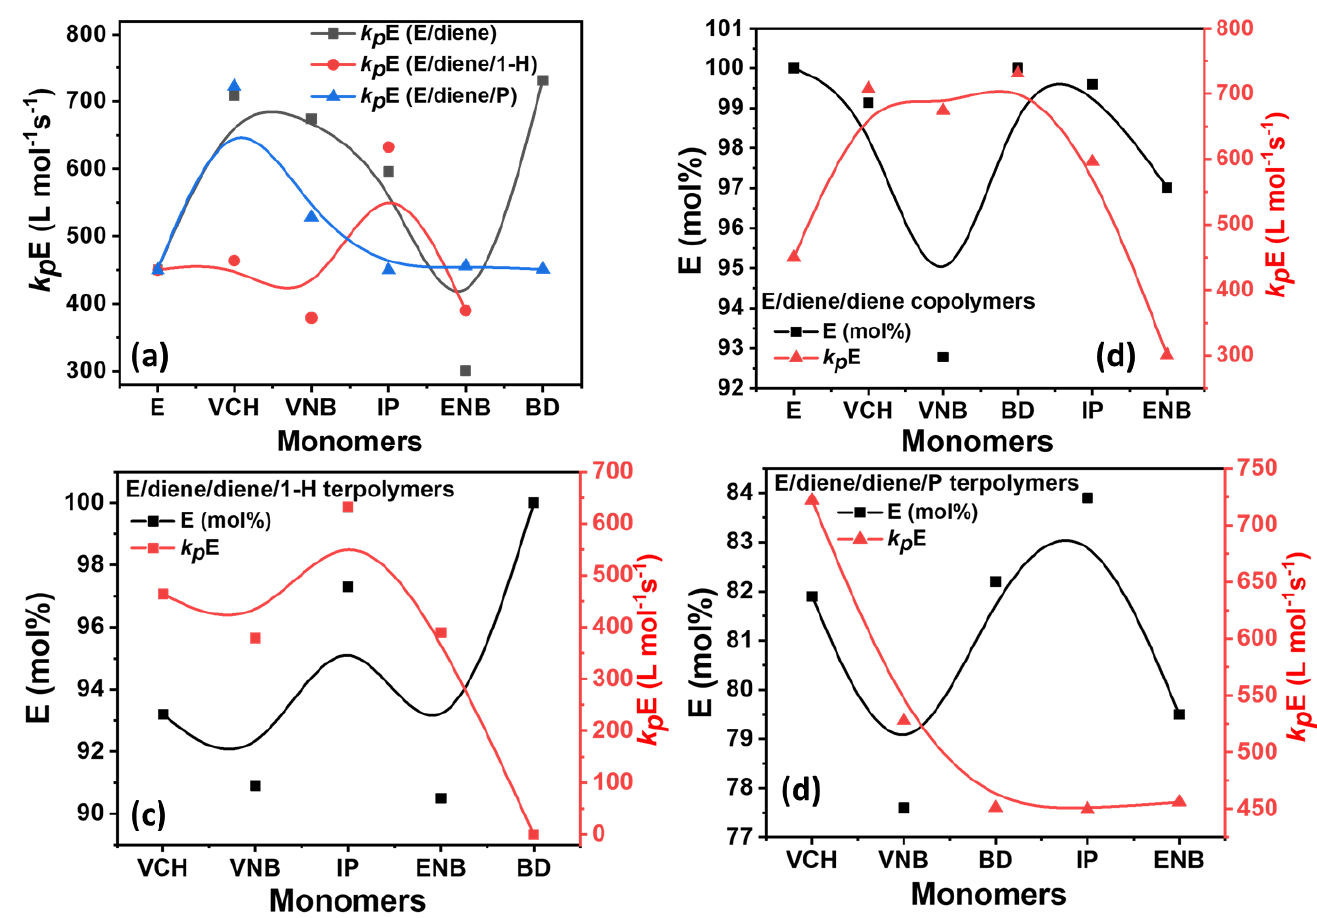
Figure 6. ( a ) Comparison of k p E value of E/diene, E/diene/1-hexene and E/diene/P polymerizations; ( b – d ) correlations between k p E value and E mol% in E/diene, E/diene/1-hexene, and E/diene/propylene polymerizations, respectively.